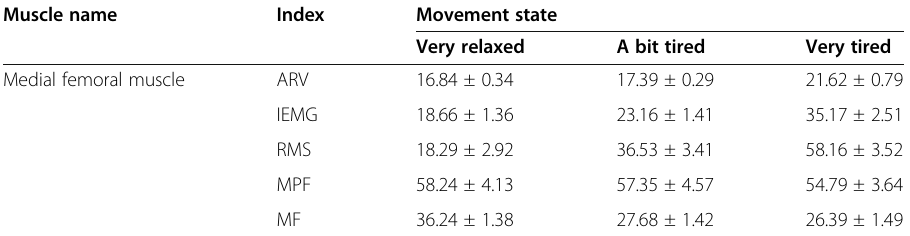
Table 3 Medial femoral electromyography indexes of different exercise states